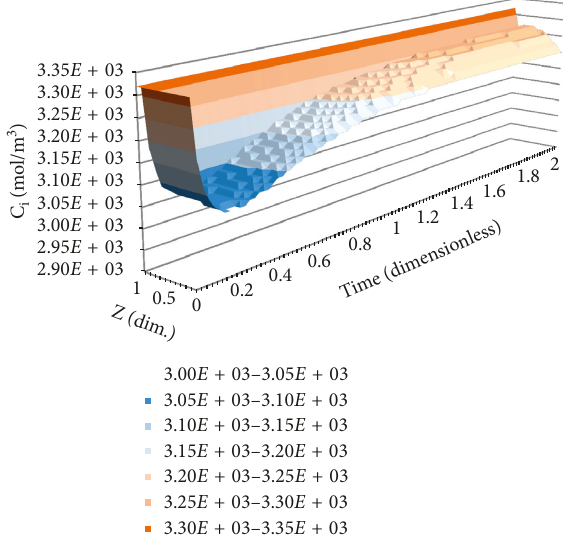
Figure 7: MEA axial concentration profile variation with time.